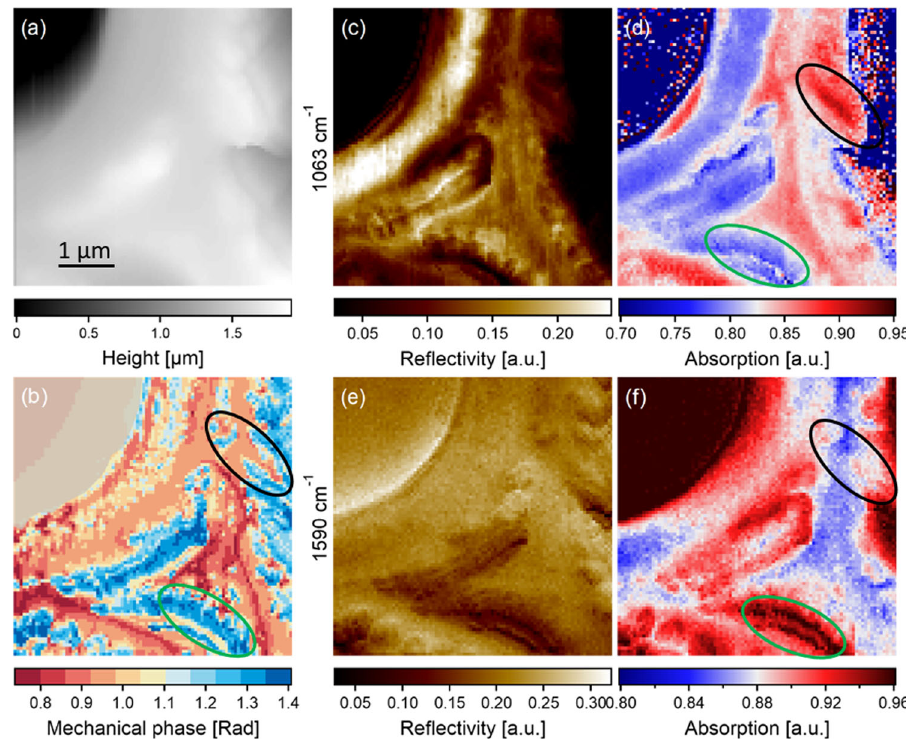
Fig. 2 Nanomechanical and nanospectroscopic imaging of PCWs. Results are shown for measurements on a 5 × 5 µ m 2 region of a poplar cross-section. The signals comprise topography ( a ), mechanical phase ( b ), normalized re fl ectivity ( c and e ), and normalized IR absorption ( d and f ) at speci fi c spectral peaks of cellulose (1063 cm − 1 ) and lignin (1590 cm − 1 ). The black and green ovals mark cellulose and lignin-rich regions, respectively, and highlight the correlation between the mechanical phase and the IR absorption